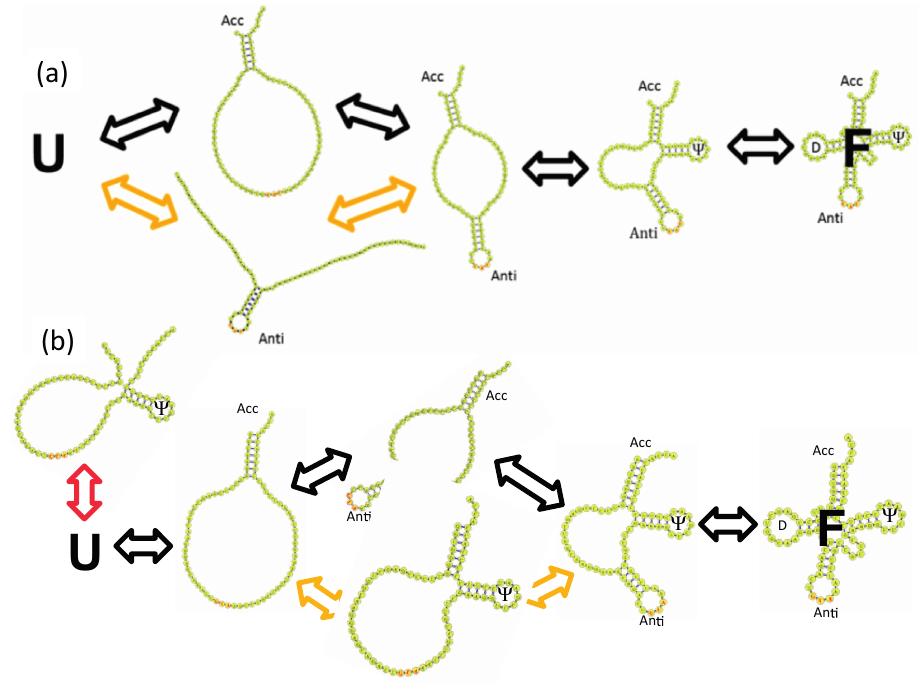
Figure 6. Folding mechanism of tRNAs inferred from TIS model MD simulations. ( a ) Parallel folding mechanism of E. coli. tRNA fMet ; ( b ) Parallel folding mechanism of E. coli. tRNA Tyr with backtracking of the Ψ hairpin loop. U and F refer to the unfolded and folded states, respectively. The black arrows represent the dominant mechanism with the lowest free energy barriers, the yellow arrows represent a parallel mechanism with higher free energy barriers, and a red arrow in ( b ) represents a backtracking